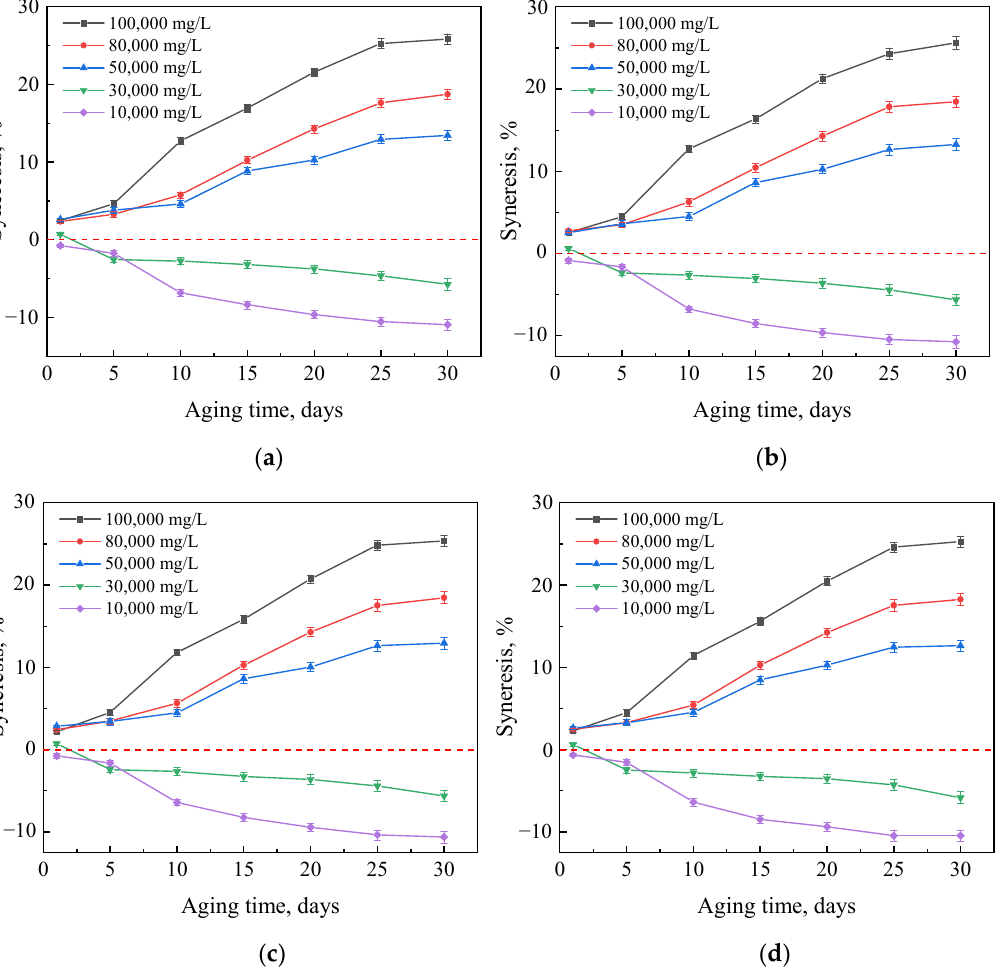
Figure 9. Mass changes of different gels after aging in brines with different salinities for different times: ( a ) Gels consist of 0.5 wt% G3515, 0.5 wt% crosslinker, and 0.3% stabilizer; ( b ) Gels consist of 0.5 wt% G3515, 1.0 wt% crosslinker, and 0.3% stabilizer; ( c ) Gels consist of 0.75 wt% G3515, 0.5 wt% crosslinker, and 0.3% stabilizer; ( d ) Gels consist of 0.75 wt% G3515, 1.0 wt% crosslinker, and 0.3% stabilizer.